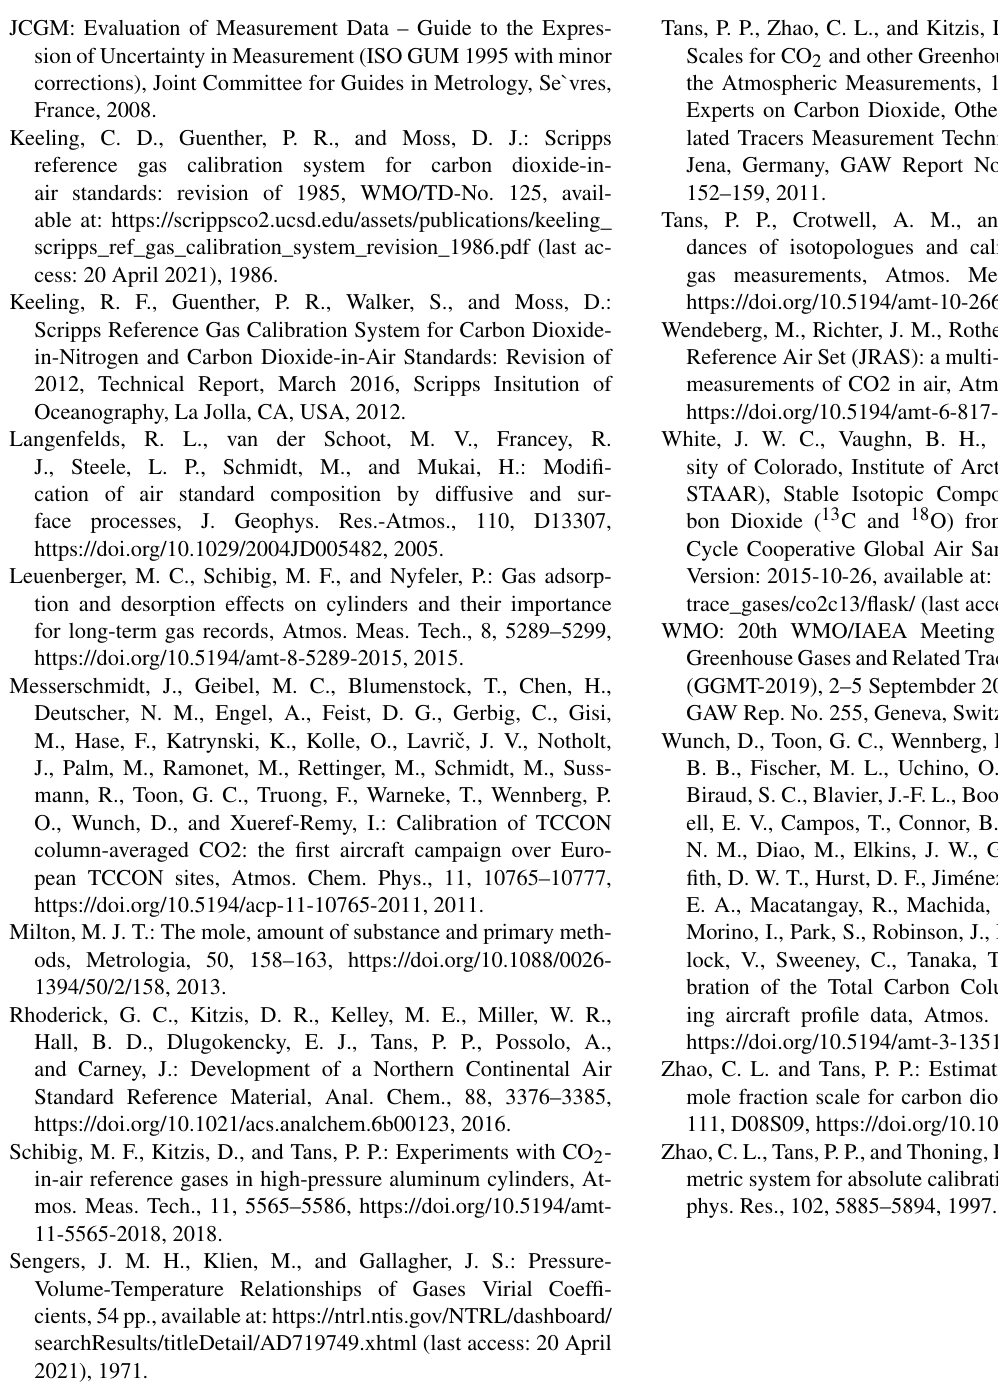
JCGM: Evaluation of Measurement Data – Guide to the Expres- sion of Uncertainty in Measurement (ISO GUM 1995 with minor corrections), Joint Committee for Guides in Metrology, Se`vres, France,